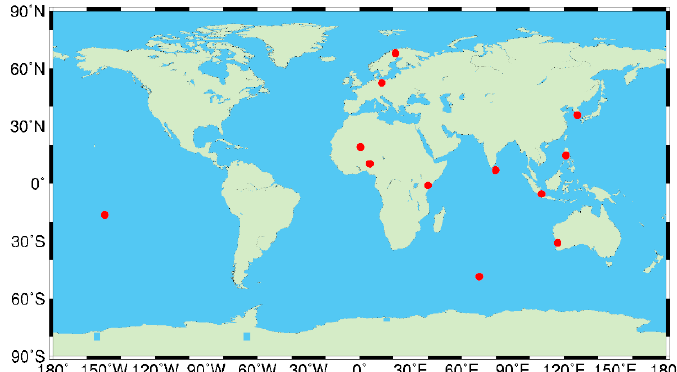
Figure 1. Geographical distribution of the 12 global MGEX tracking stations.